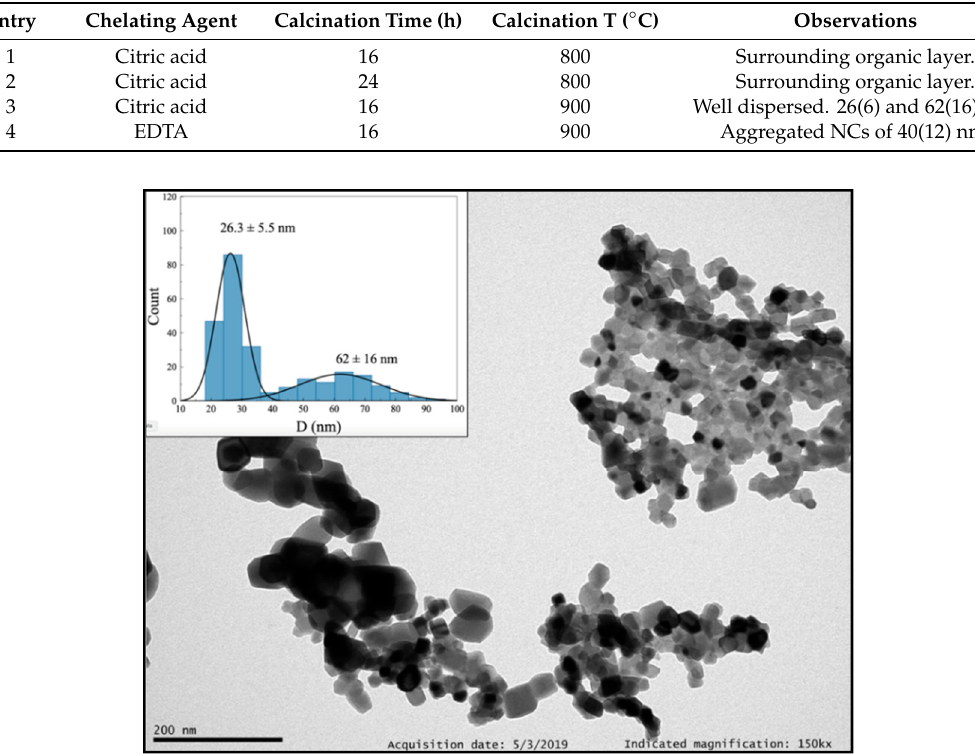
Figure 6. TEM image of Y 2 O 3 : Pr 3+ NCs obtained by sol–gel Pechini method using citric acid as chelating agent and followed by thermal treatment at 900 °C for 16 h.